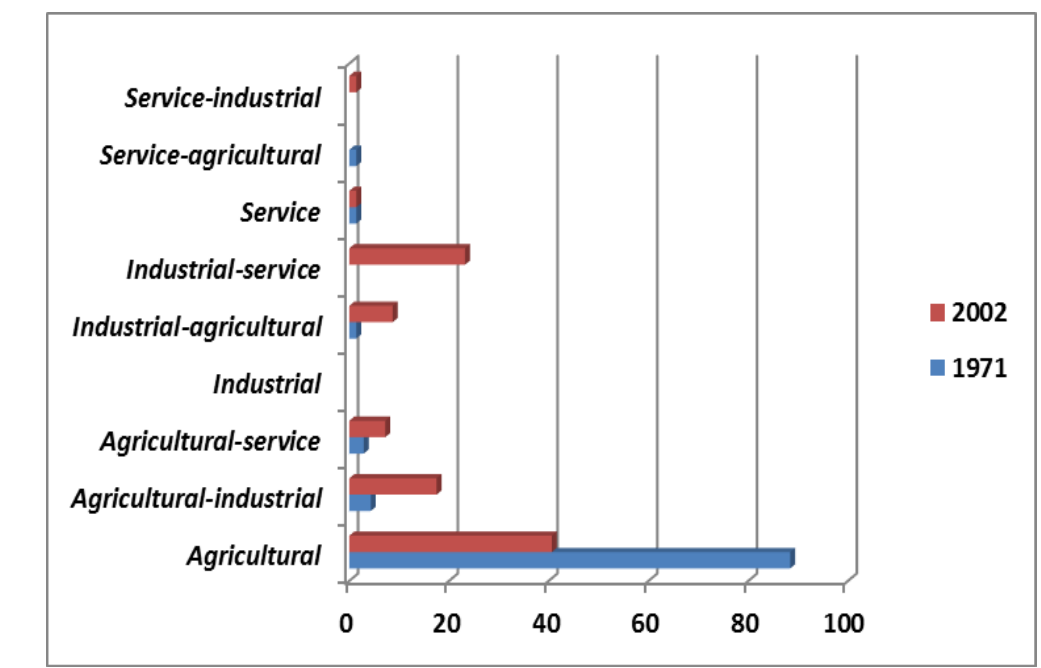
Fig. 2. Changes of functional types of Serbian settlements between